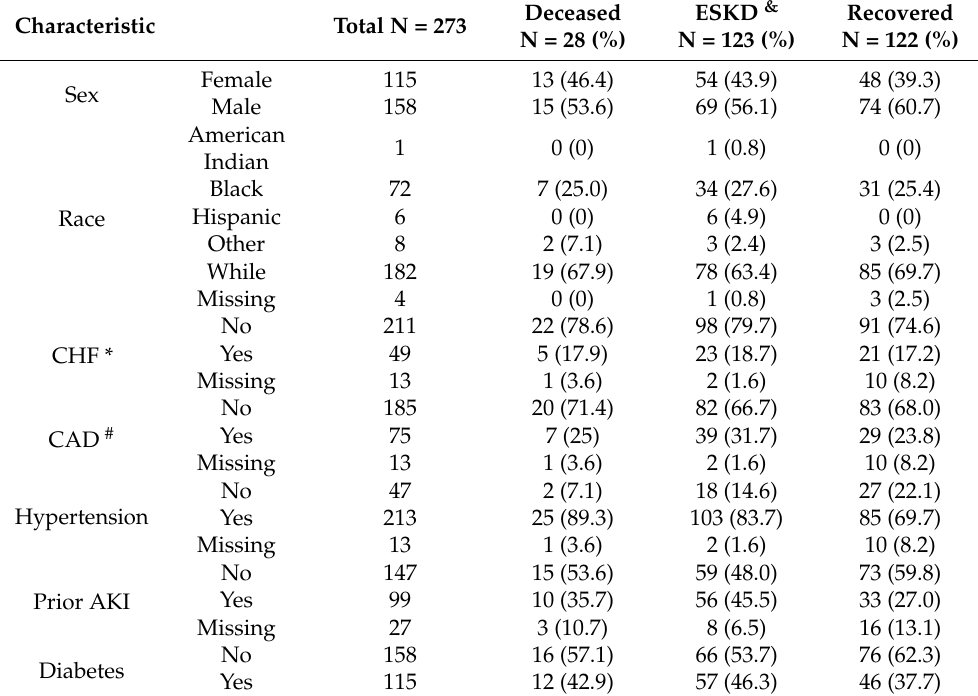
Table 1. Study Patient